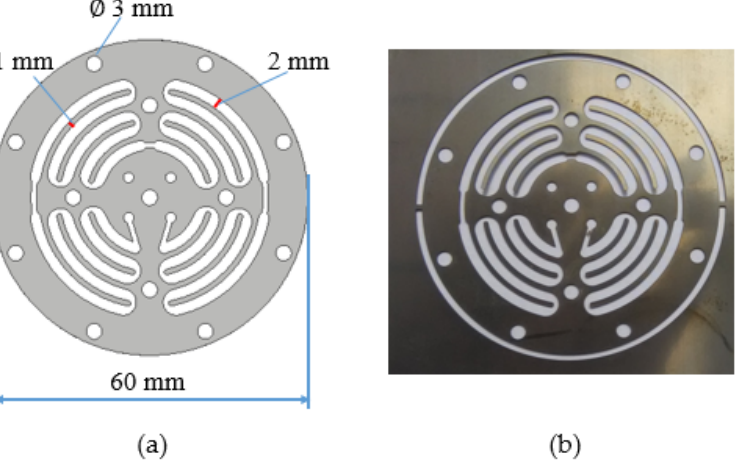
Figure 1. Microfluidic channel. ( a ) Design of microfluidic channel; ( b ) microfluidic channel fabricated using wire EDM (rough machining).